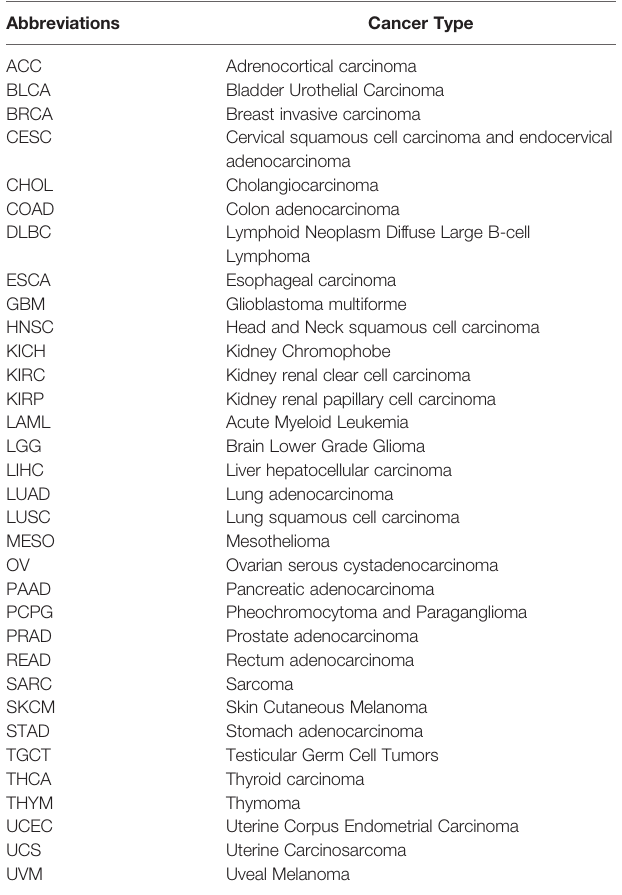
TABLE 1 | TCGA cancer abbreviations and the corresponding cancer